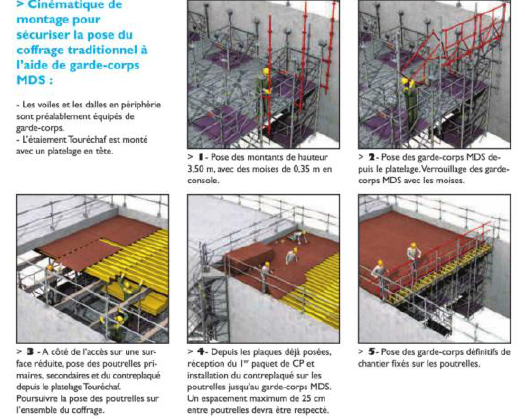
Fig. 1. An example of installing scaffolding for slab formwork in a supplier catalogue MILLs formwork.